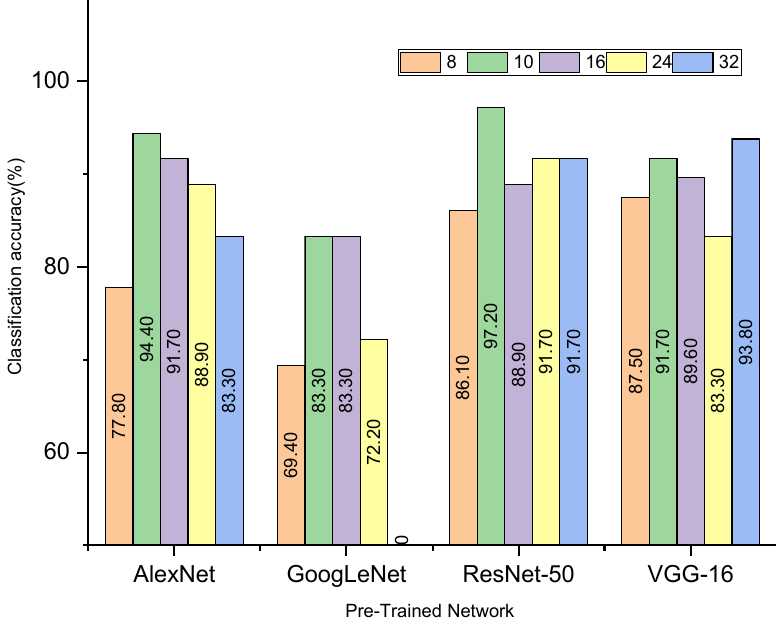
Figure 11. Pretrained model performance for varied batch sizes.